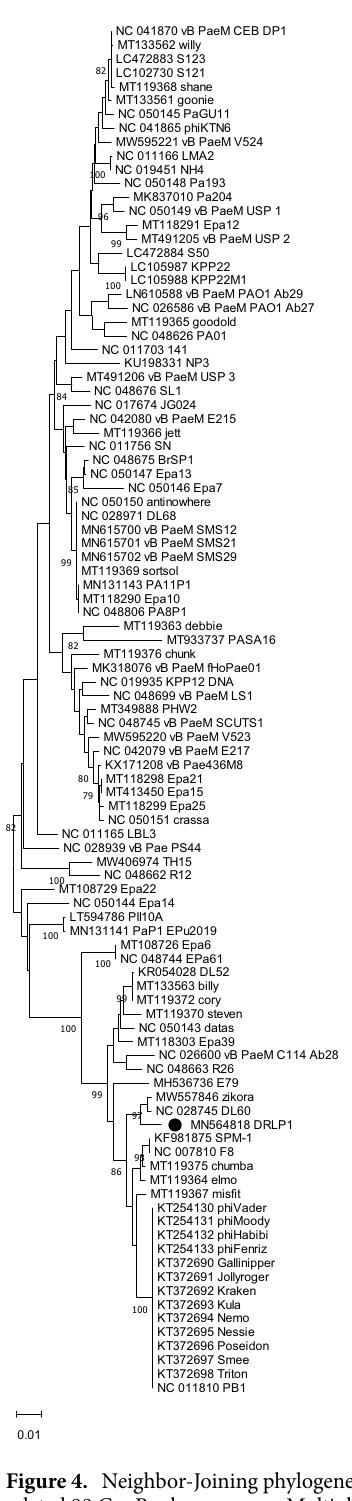
Figure 4. Neighbor-Joining phylogenetic tree based on the large terminase gene sequences from DRL-P1 and related 98 GenBank sequences. Multiple sequences were aligned using the MAFFT online server. Evolutionary distances were calculated using the Maximum Composite Likelihood method implemented in MEGA X computer program. Numbers below the branches represent percentage of replicate trees, where the associated taxa clustered together during the bootstrap test (1000 replicates). The optimal tree is drawn to scale with branch lengths signifying the evolutionary distances used to infer the tree. A total of 1383 positions were available in the final dataset for evolutionary analyses. Ambiguous positions were excluded from analysis. Graphical presentation of the phylogeny was generated using the MEGA X computer program, version 10.2.4 (https:// www. megas oftwa re.